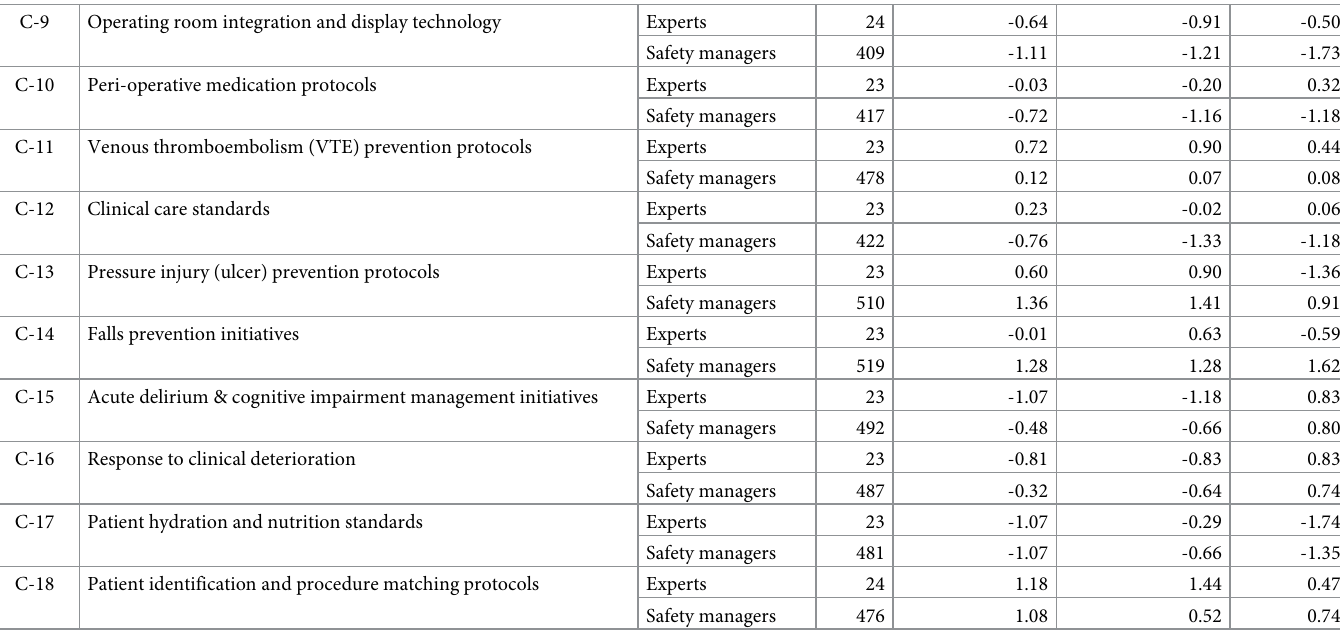
future priority. For safety managers, the evaluations of past contribution, current dissemina- tion, and future priority were in the same direction. These results suggest that safety managers are likely to evaluate future priority based on past contribution and current dissemination; however, experts are likely to evaluate future priority based on other factors.